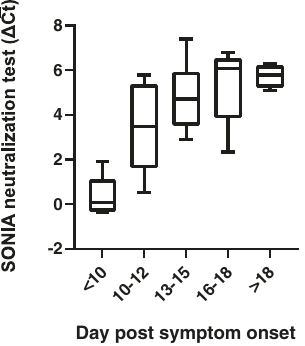
Fig. 5 Evaluation of kinetics of NAb development by the SONIA neutralization PCR test. Sera from COVID-19 patients after different days post symptom onset were tested by the neutralization PCR assay. All serum samples ( N = 28) were from unique individuals. The y-axis is the SONIA neutralization PCR test signal Δ Ct calculated by subtracting the Ct value of the sample from that of a buffer only blank control. The boxplots show medians (middle line) and 75th and 25th quartiles (upper and lower boxes), while the whiskers show the minimum and maximum of the data.